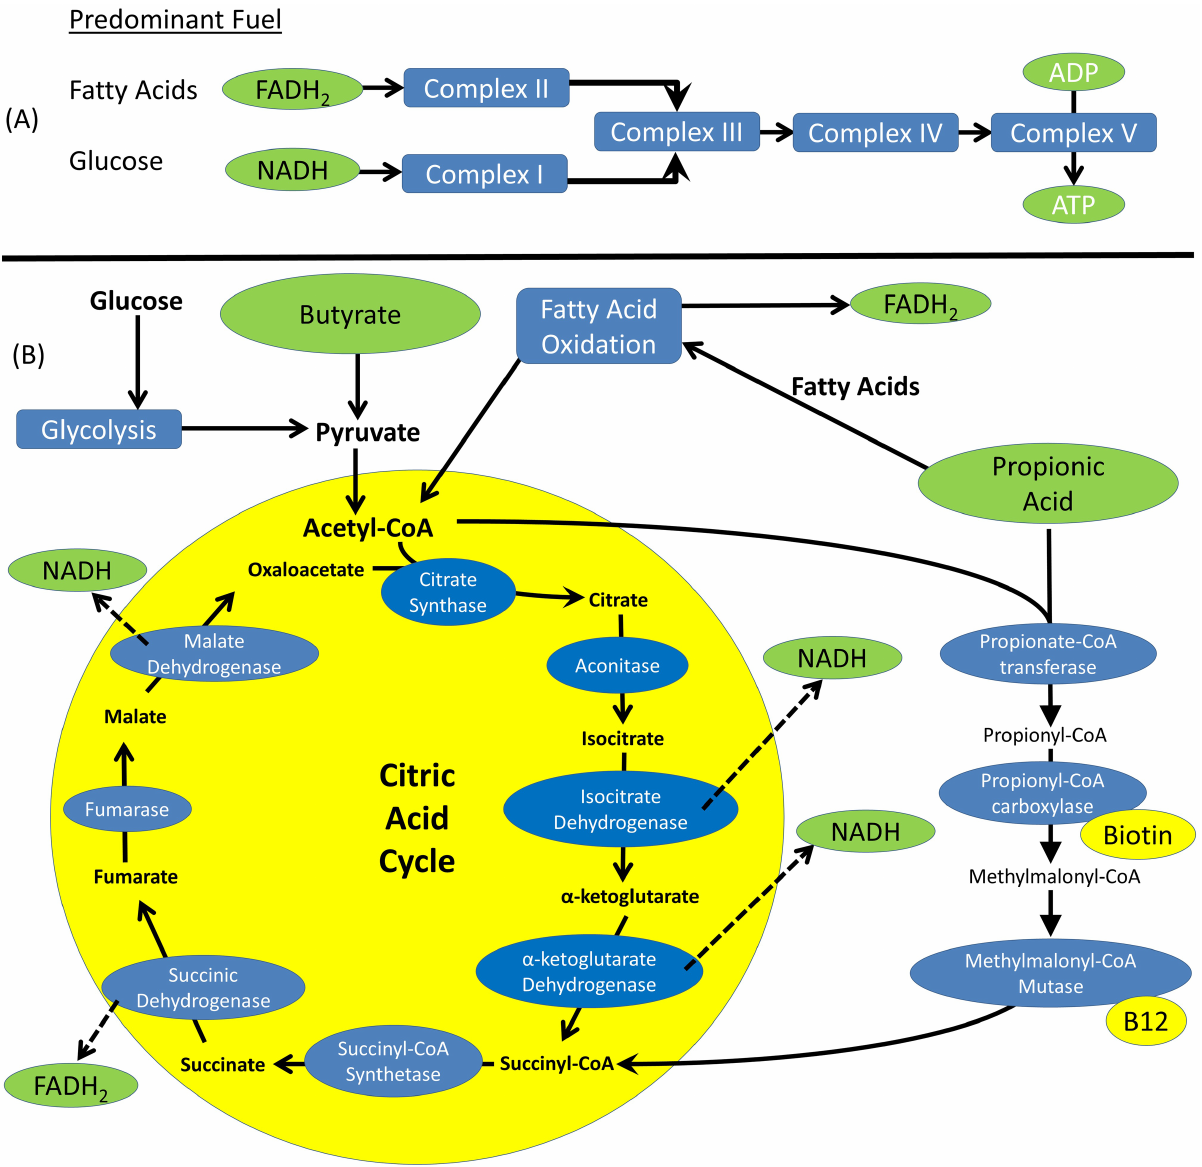
Fig 1. Mitochondrial pathways utilize short chain fatty acids as substrates. (A) The electrontransport chain has two distinct starting points, Complex I and ComplexII, each of which have a predominant fuel source. ComplexesIII, IV and IV are common to both of these pathways. (B) Butyrate and PropionicAcid enter mitochondrial metabolismthrough two slightly overlappingpathways. Butyrate enters the citric acid cycle through its key substrate Acetyl-CoA, similar to glucose.The citric acid cycle predominantly producesNADH that is the substrate for Complex I. Propionicacid can be metabolized through two different pathways, both of which result in a relativelygreater productionof FADH 2 that is the substrate for Complex II. Propionicacid can producefatty acids that are then the substrates for fatty acid oxidation.Propionicacid can be metabolized through several enzymes resultingin bypassingthe first half of the citric acid cycle and using up